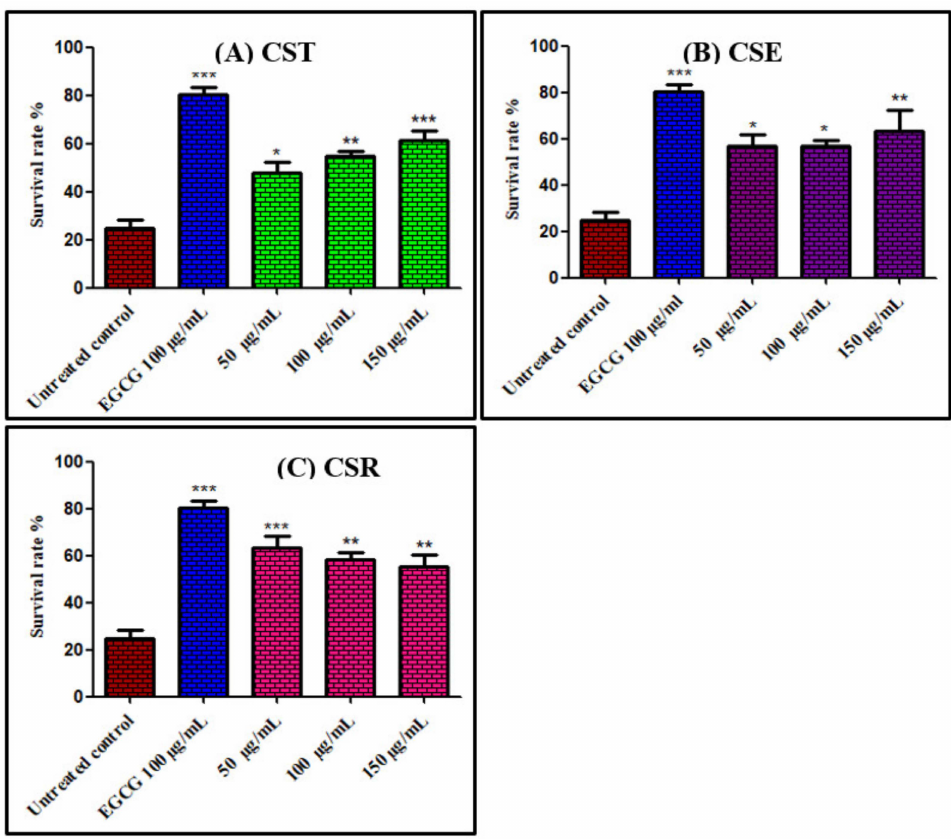
Figure 1. Survival rate of Caenorhabditis elegans pre-treated with different concentrations (50, 100, and 150 µ g/mL) of extracts and fractions of C. speciosum leaves; ( A ) CST, ( B ) CSE, and ( C ) CSR; untreated control receives juglone treatment; EGCG = Epigallocatechin gallate (100 µ g/mL) after juglone treatment; CST, CSE, and CSR groups receive (50, 100, and 150 µ g/mL) of CST, CSE, and CSR after juglone treatment; * p < 0.05, ** p < 0.01, and *** p <